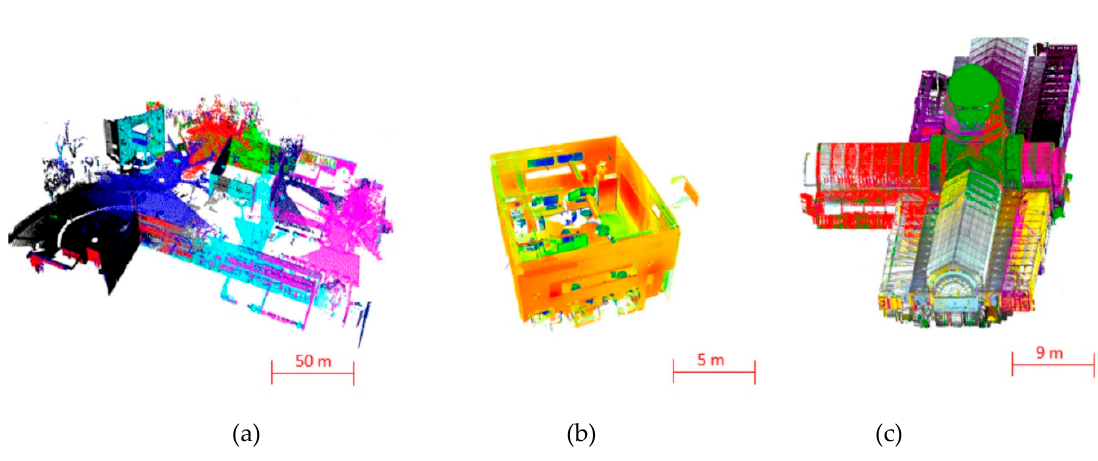
Figure 8. 3D globally consistent point clouds obtained with the proposed method: ( a ) “Patio batel” dataset, ( b ) “Lape” dataset, and ( c ) “Royal exhibition building” dataset.